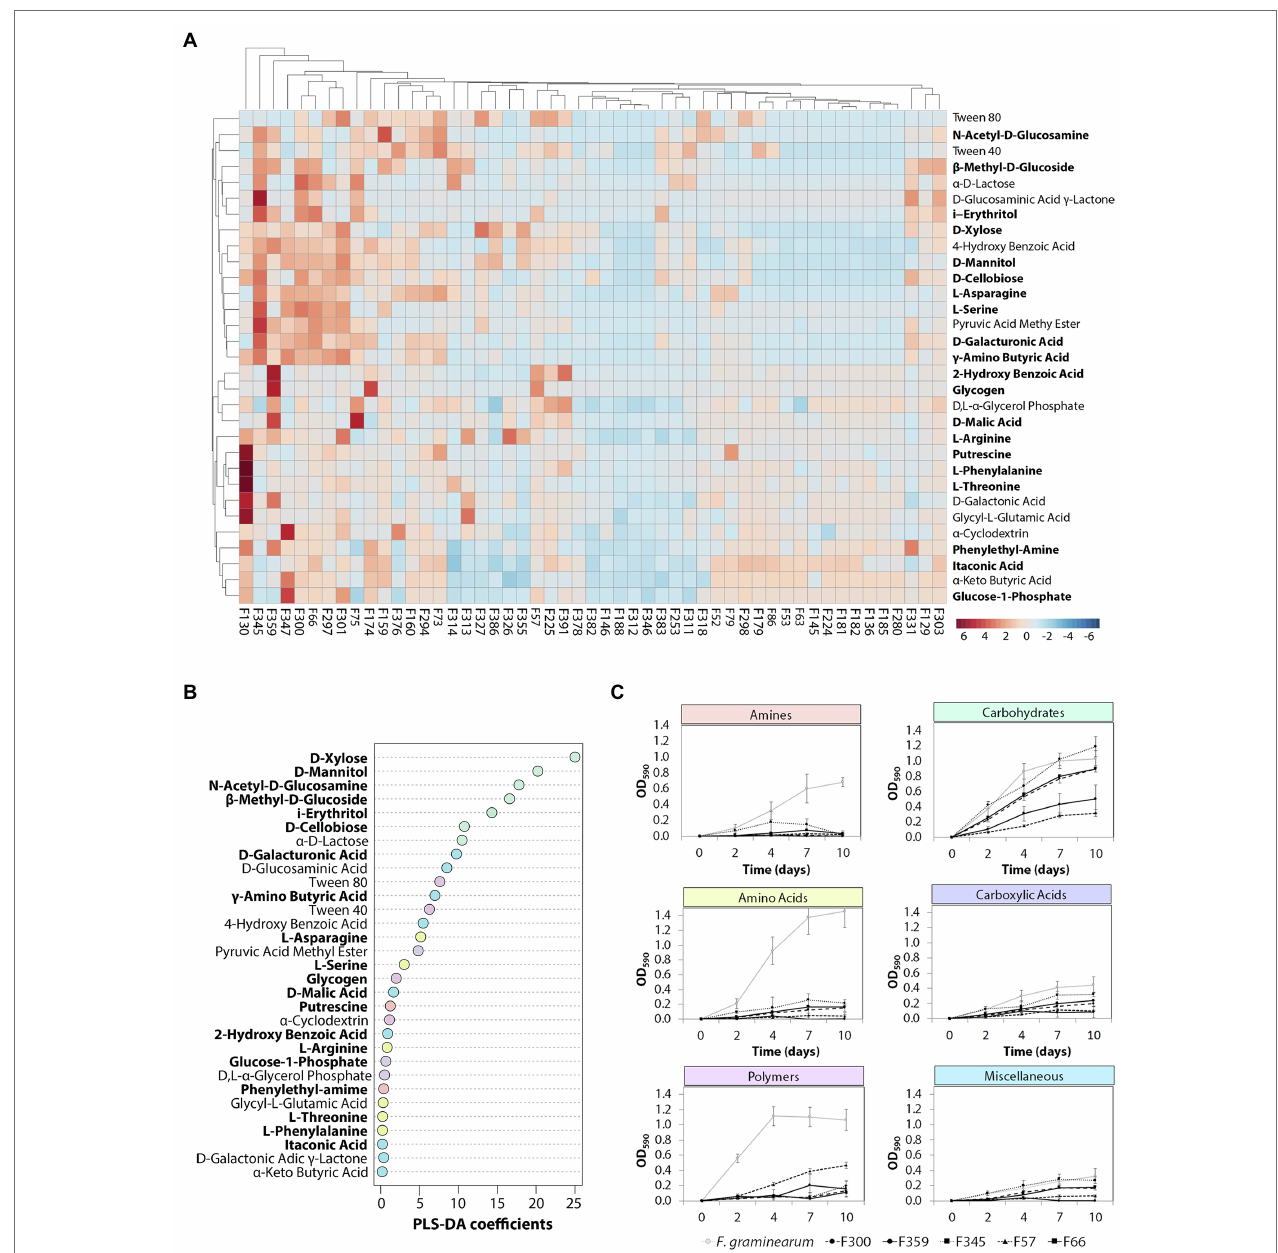
FIGURE 3 | Metabolic profiling of the phyllosphere yeasts. (A) Hierarchical cluster and heat-map analyses of nutrient sources utilized by the selected yeast isolates performed with MetaboAnalyst. Yeast isolates were inoculated (OD 600 = 0.01) in the BIOLOG EcoPlates, incubated for 10 days at 25 ° C and 180 rpm, growth was measured with a plate reader at OD 590nm . Columns represent the average of three replicates of each of the 51 isolates. Rows represent the different carbon sources (blue: low abundance, red: high abundance). Compounds of plant and/or microbial origin are displayed in bold. (B) Partial least squares-discriminant analysis (PLS- DA) indicating the importance of each carbon source. (C) The dynamics of the top 5 isolates including F. graminearum with the most diverse metabolic profile per carbon